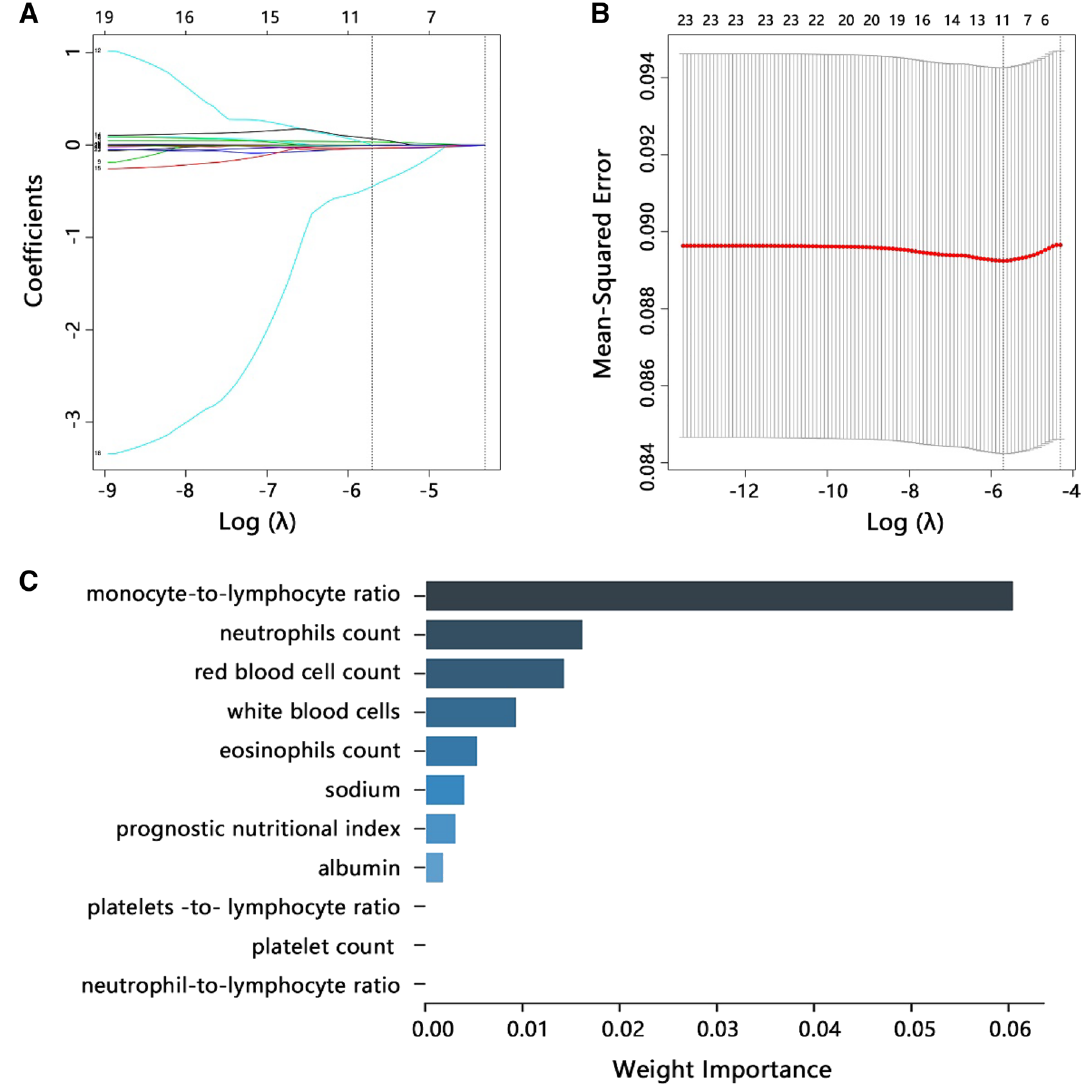
Figure 1. Variables selection associated with positive QFT-GIT using LASSO regression analysis. ( A ) LASSO coefficient of 23 laboratory variables. ( B ) Ten-fold cross-validation for tuning parameter selection in the LASSO model. ( C ) Weight importance evaluation of nonzero